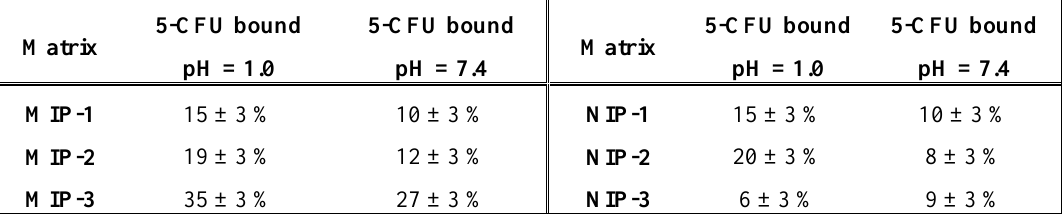
Table 3. Percentage of bound 5-FU by the imprinted and non-imprinted polymers after 24 hours in aqueous media (i.e., pH=1.0 and 7.4)